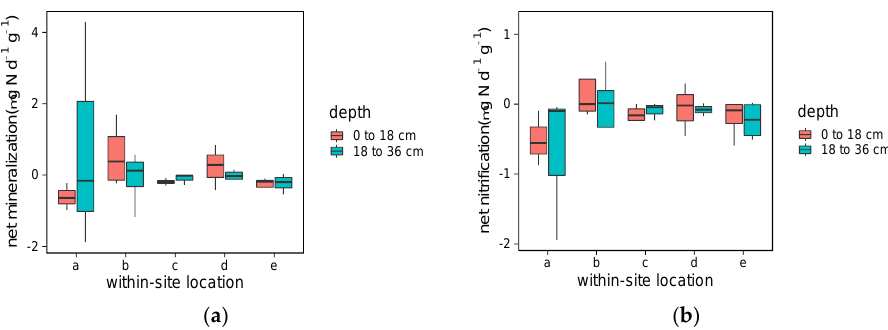
nitrification ( p = 0.639, n = 36) (Figure 3).